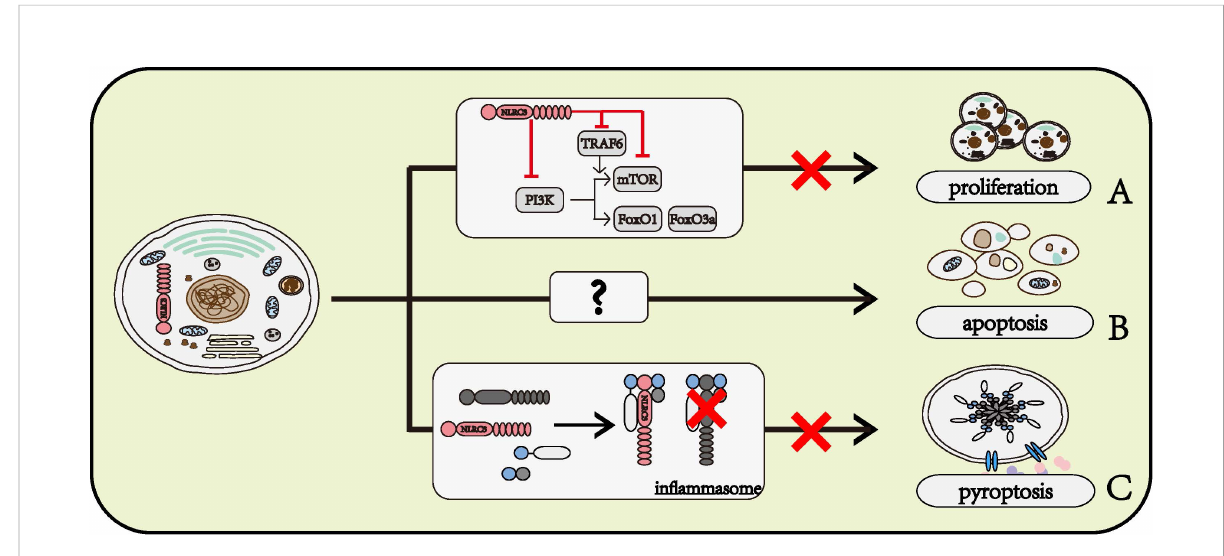
FIGURE 3 Roles of NLRC3 on cell fates. (A) NLRC3 inhibits cell proliferation. NLRC3 interferes the normal function of PI3K or inhibits the activation of mTOR through directly regulating itself and interfering TRAF6, thereby preventing its downstream molecules mTOR, FoxO1 and FoxO3a, and further regulate the cell proliferation. (B) NLRC3 might promote the cell apoptosis. (C) NLRC3 prevents the interaction with ASC and pro-CASP1, further inhibit the formation of in fl ammasome and cell